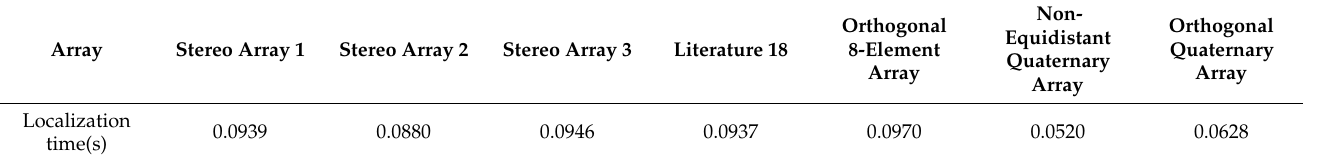
Table 1. The localization processing time.